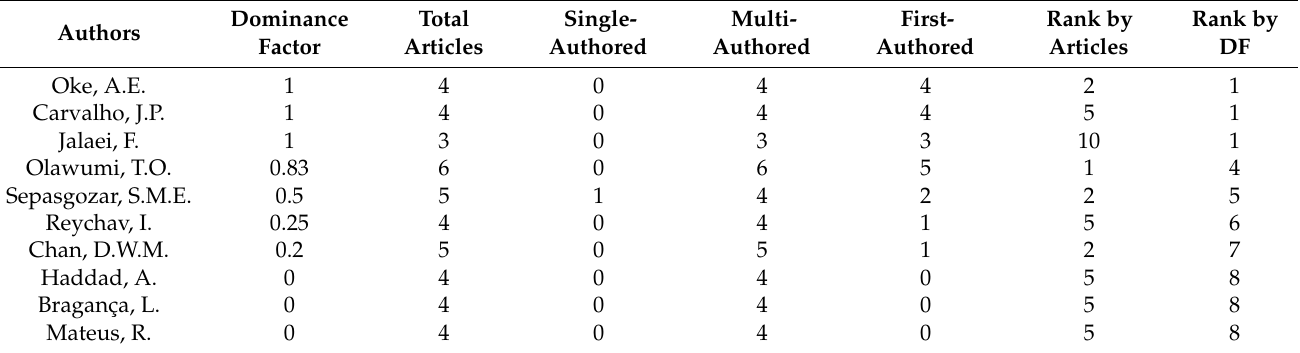
Table 9. Author dominance factor and number of published